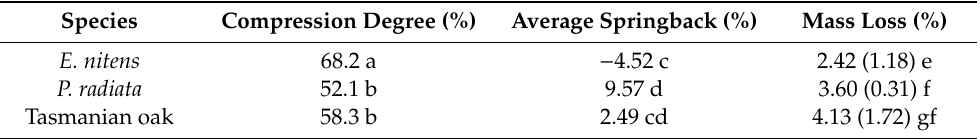
Table 4. Average springback (%), compression degree (%), and mass loss (%) for the three species tested ( n = 30). Standard deviation presented in parentheses ( n =